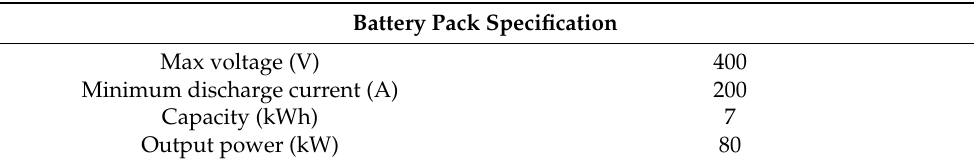
Table 3. Requirements of battery pack.